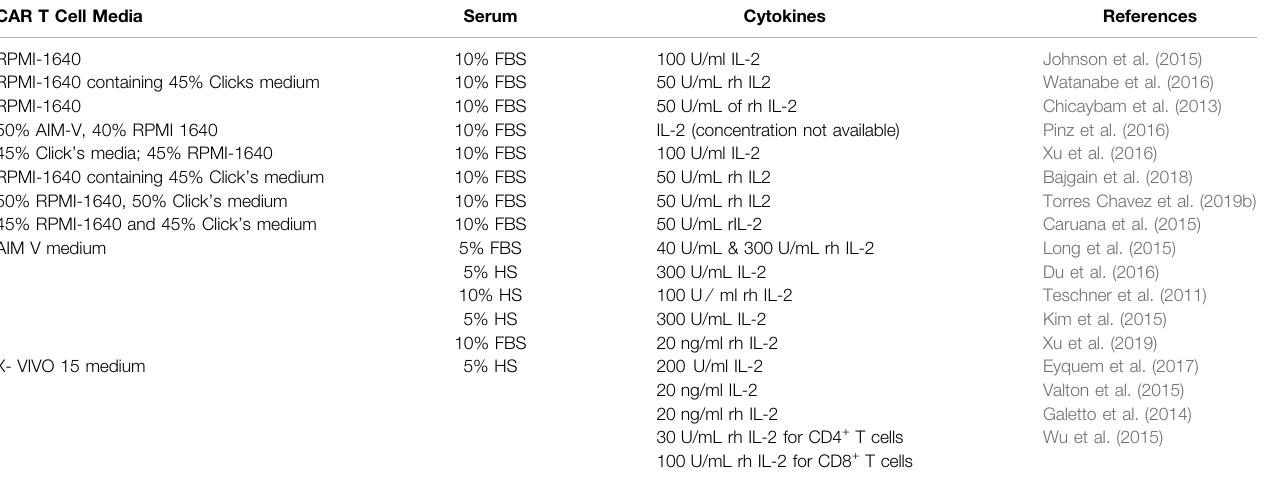
TABLE 1 | Currently used media formulation for ex vivo expansion of CAR T cells. CAR T Cell